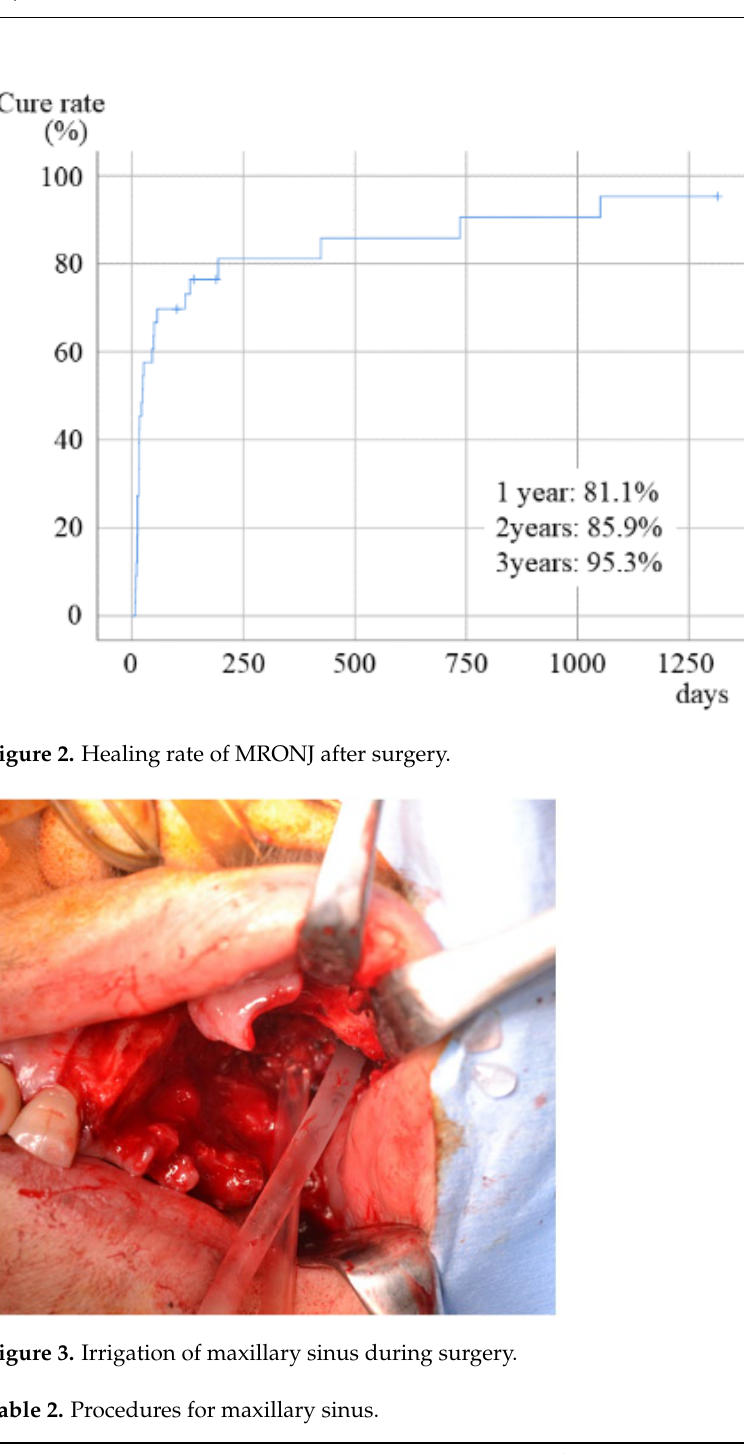
Figure 2. Healing rate of MRONJ after surgery.